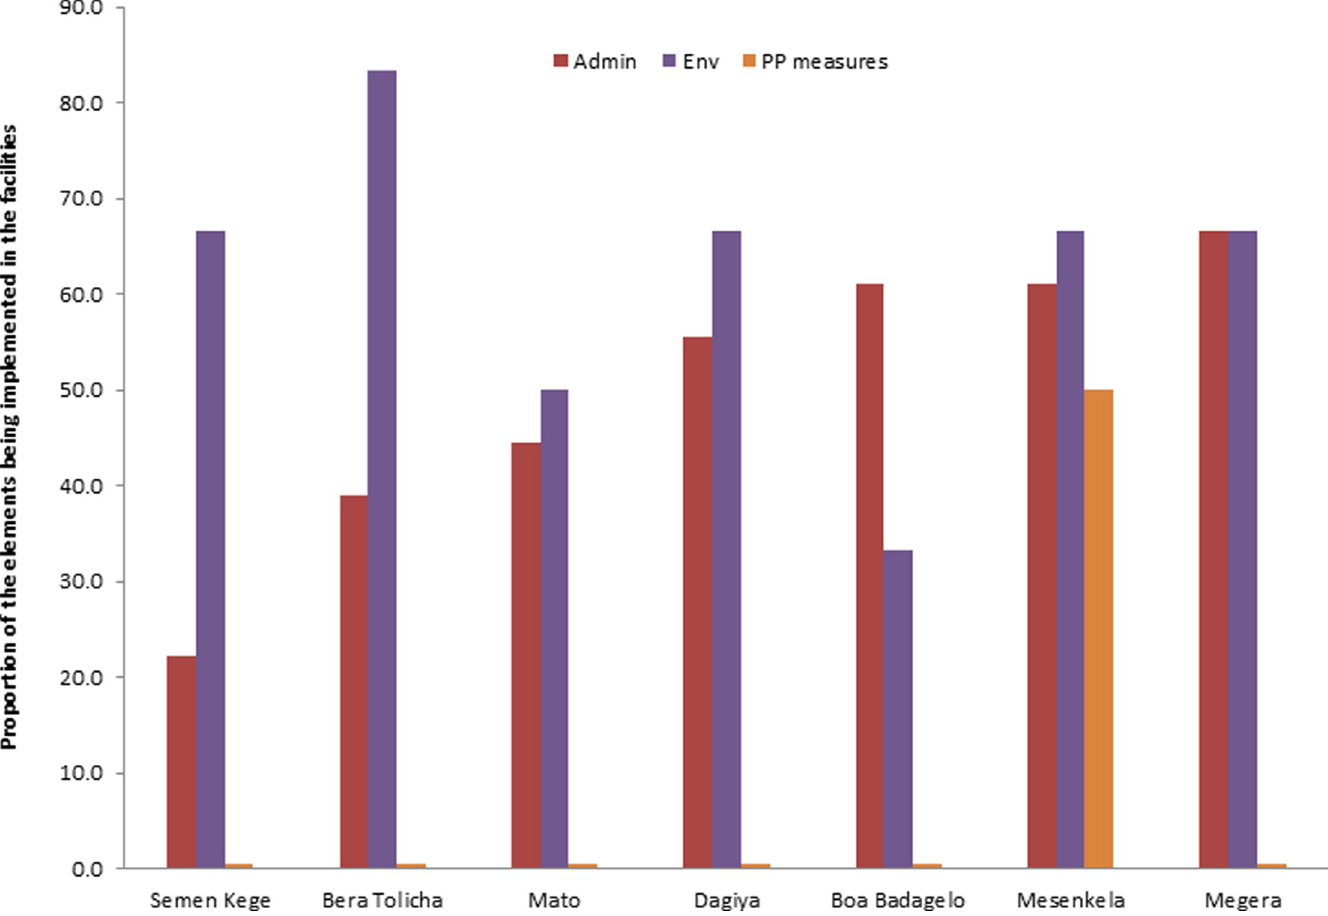
Fig 5. The three hierarchies of TB infection control program for each studied health facilities in Dale district, Sidama Zone, Southern Ethiopia.